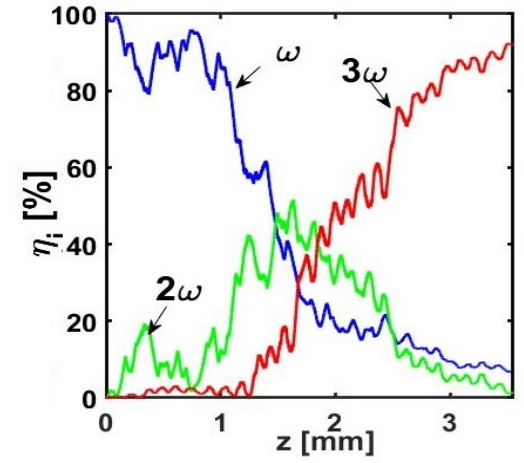
Figure 5. Same as in Figure 4 but for equal domain sizes in each segment.